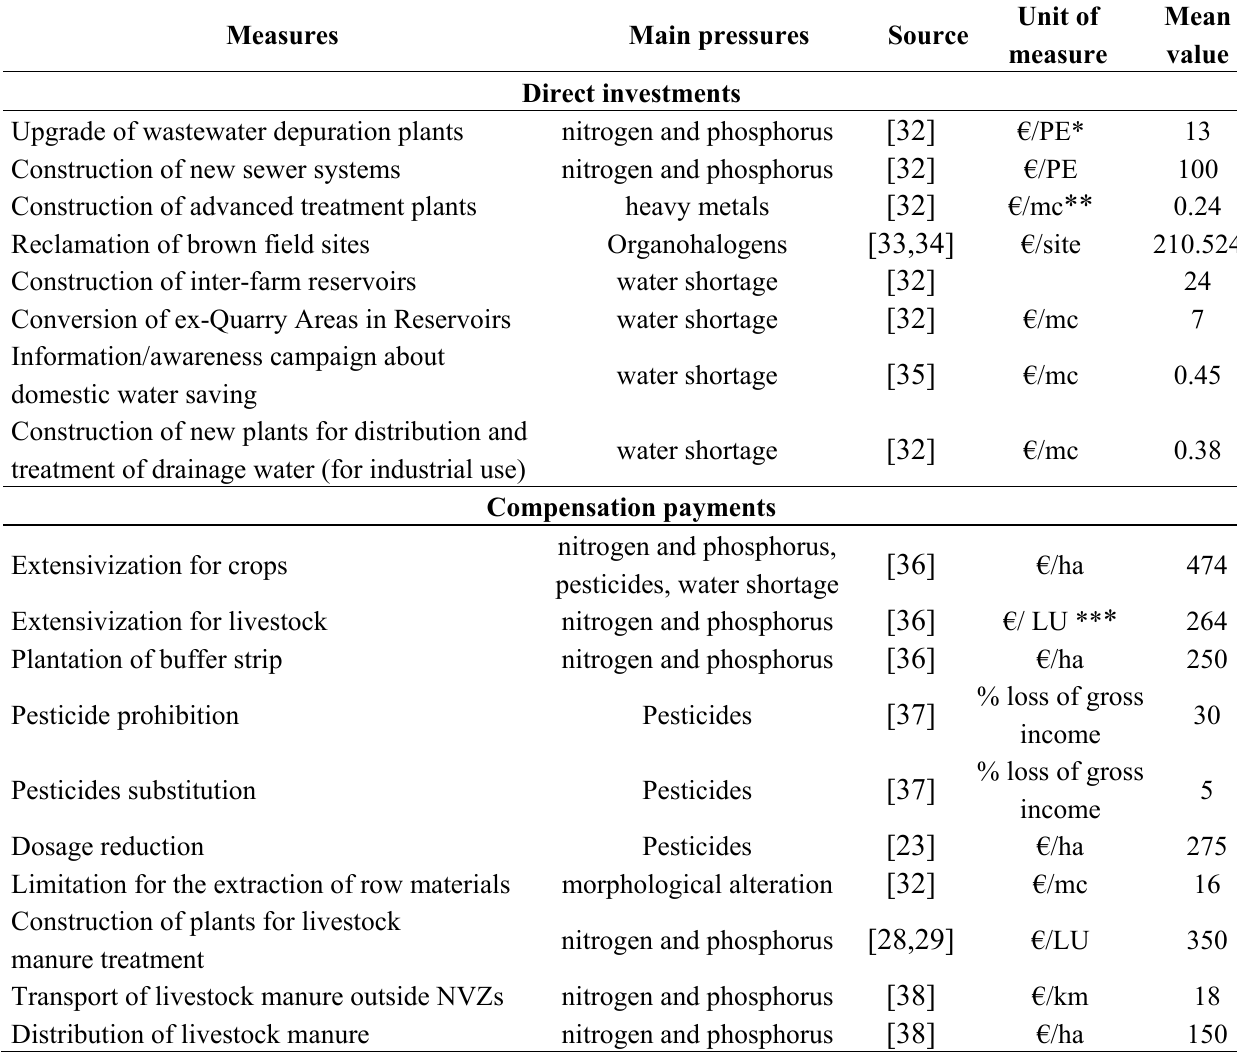
Table 2. Average annual unit cost estimates for each measure (acronyms of data source are defined in the